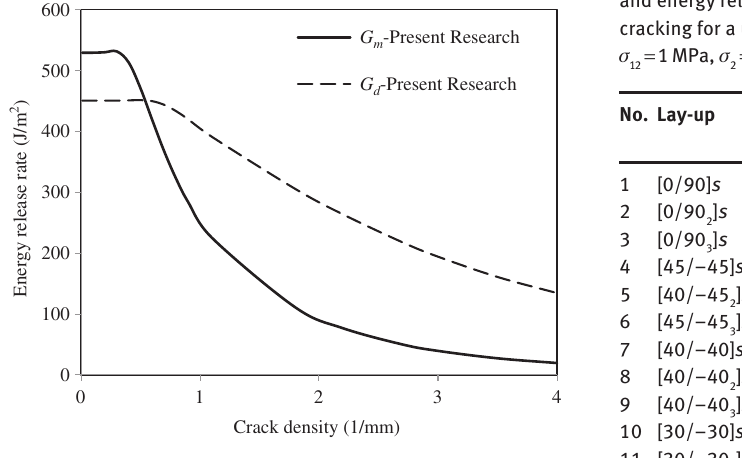
] s carbon/ 3 = 100 MPa, σ = 1 MPa and σ = 10 MPa. 1 12 2